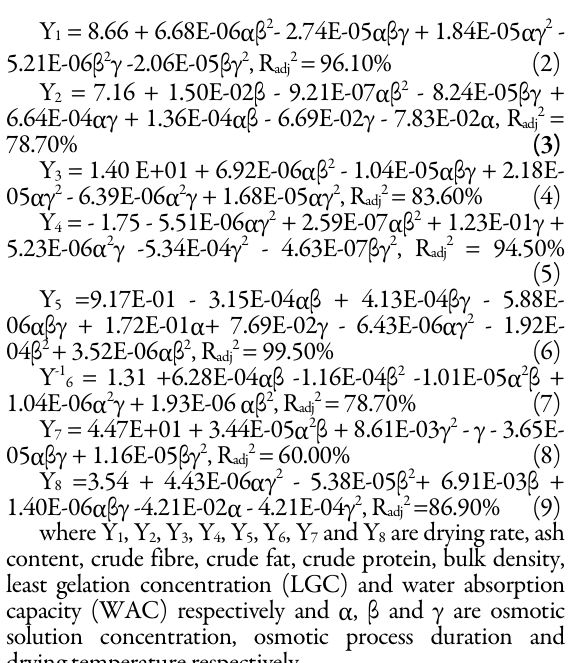
Fig. 1. General view of the laboratory dryer showing the component parts